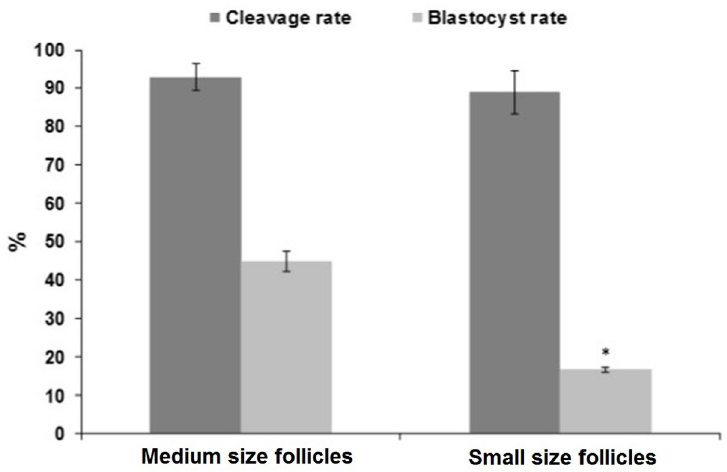
Fig 2. Developmental competency of in vitro conventional maturation of COCs derived from medium ( > 4 to 6 mm) compared to small (2 to � 4 mm) size follicles. 5 replicates and minimum number of oocytes in each replicate were 50. Culture medium was conventional maturation medium containing TCM + LH (10 μ g/ml) + FSH (10 μ g/ml) + IGF (100ng/ml) + EGF (10ng/ml) + Cys (0.1mM) + FBS (15%) + E2 (1 μ g/ml). The asterisk represents a significant difference (P < 0.05) within columns with the same